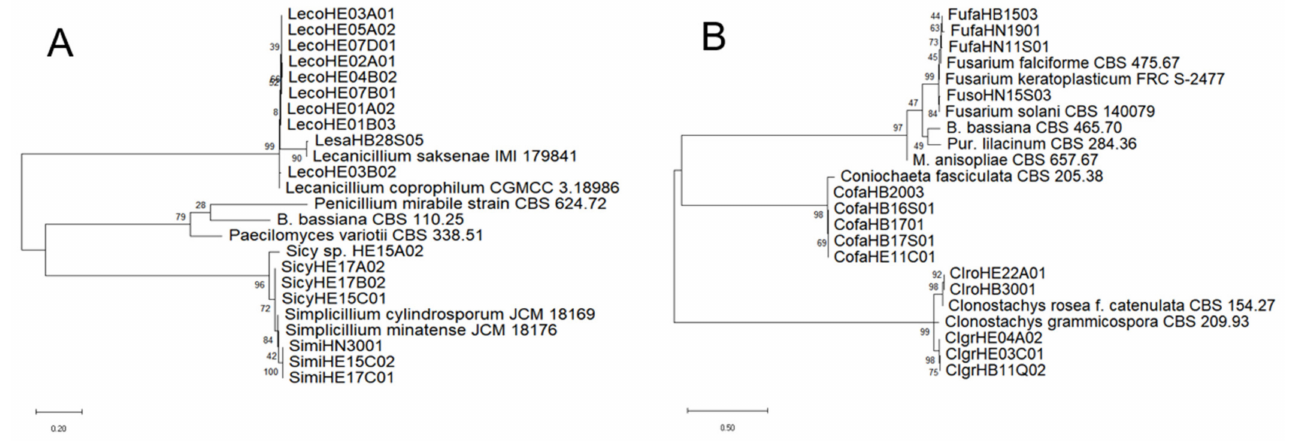
Figure 4. Phylogenetic tree of Lecanicillium / Simplicillium spp. ( A ) and Fusarium / Coniochaeta / Clonostachys ( B ) isolates.